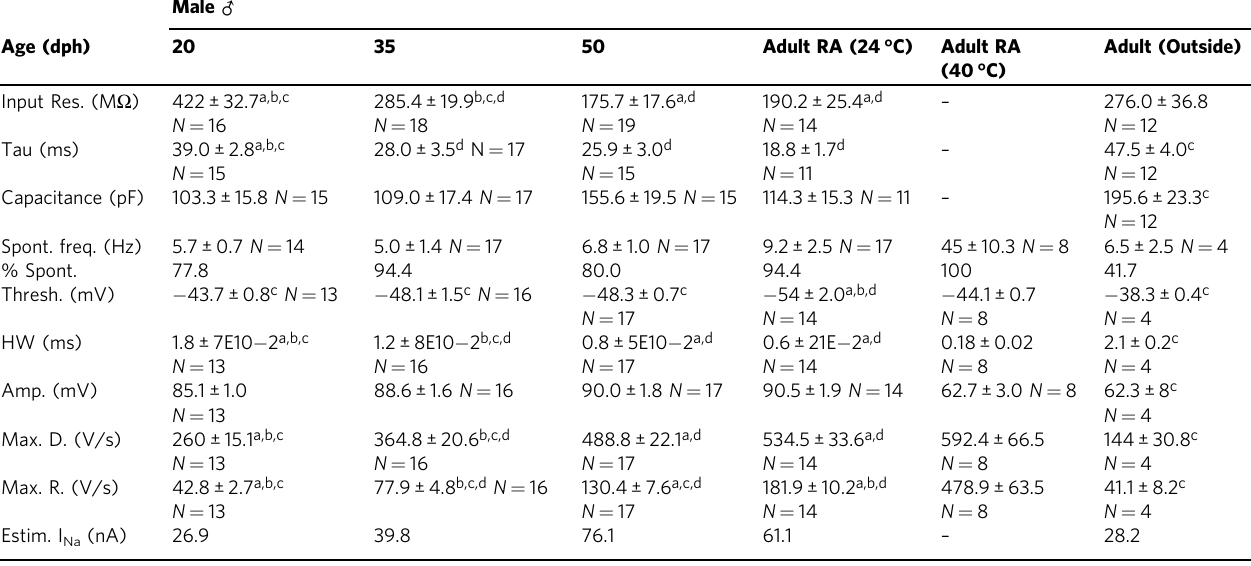
Table 1 Passive and spontaneously active properties of male arcopallial